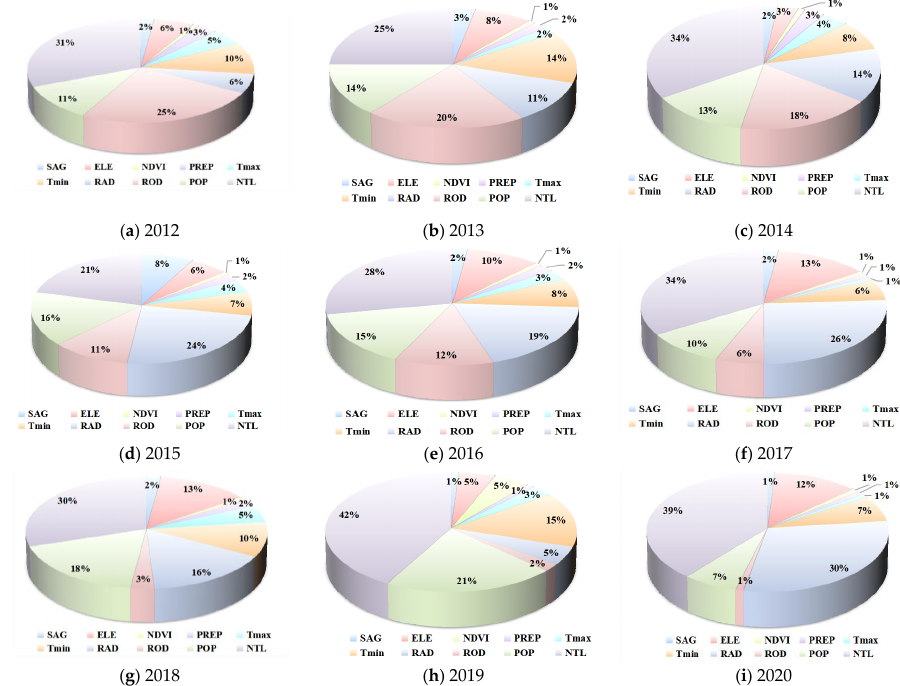
Figure 19. Spatial proportion of dominant factors from ( a ) 2012 to ( i ) 2020.